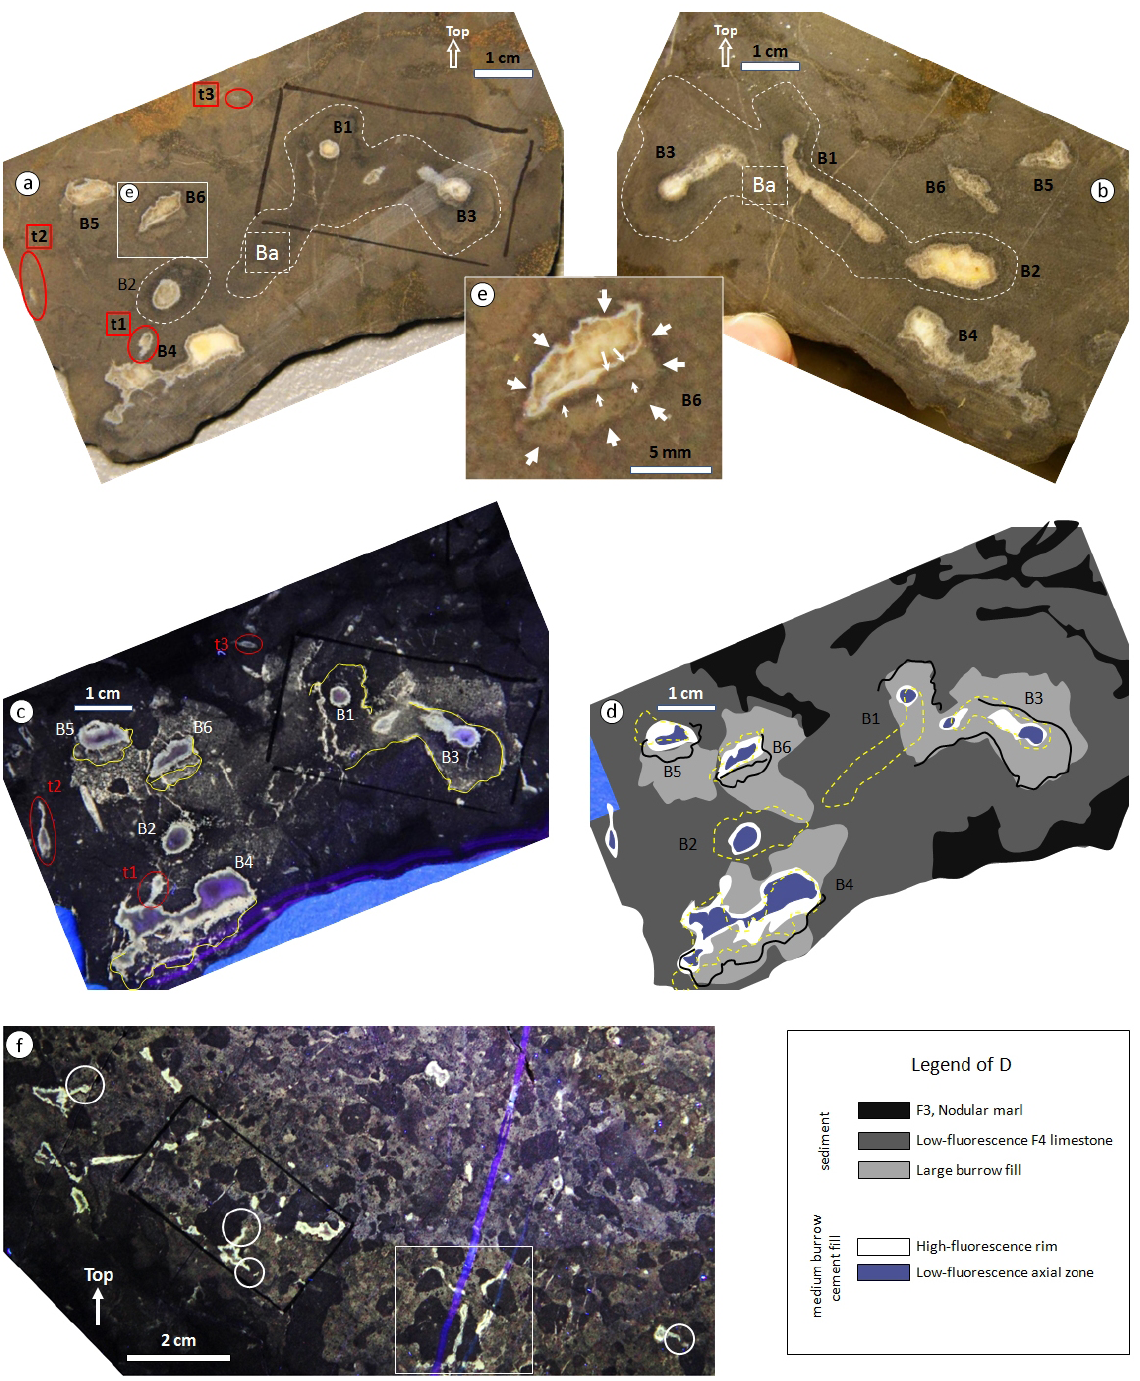
Figure 9. Burrow architecture in F4. (a, b) Opposing sides of a saw cut, ca. 3mm apart; Note three types of burrows: large burrows (one marked as Ba) surrounded by white dashed line; medium burrows (partly) filled with white-yellowish cement (labeled B1–B6); small burrows (t1–t3) encircled in red. The white rectangle in (a) is the position the close-up shown in panel (e) . (c) UV-light view of the section shown in (a) . Yellow lines follow main dark halos, as marked in (a) . (d) Line drawing of (c) ; black lines are dark halos copied from (c) , yellow dotted lines are the position of dark halos on the opposite side of the saw cut (drawn on b and flipped), illustrating changes in burrow size and orientation across the 3mm gap between the sections. (e) Close-up of B6 marked in (a) showing burrow surrounded by dark halo (bold arrows) and half-filled with geopetal sediment; thin white arrows show halos inside the geopetal filling. (f) Cross-cutting relationships between burrows (UV fluorescence). White circles point at small burrows connected to adjacent medium burrows. The white rectangle highlights longitudinal cross sections of small burrows. Black rectangles were drawn during the sample preparation process for thin section selection https://doi.org/10.5194/se-12-2439-2021 Solid Earth, 12, 2439–2466,